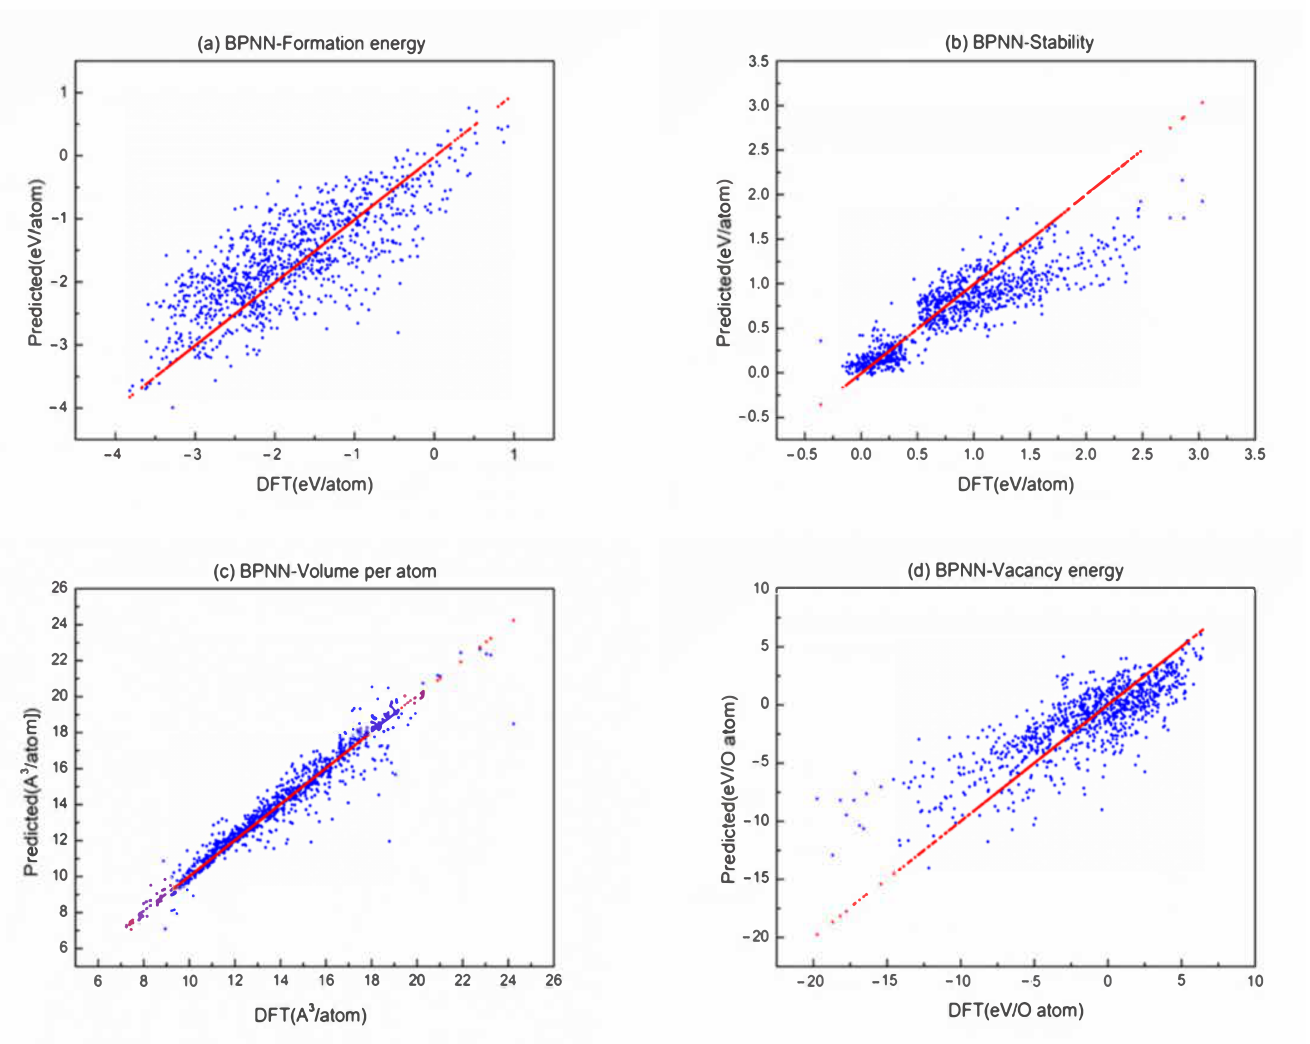
Figure 7. The fitting diagram based on the predicted value of BPNN and the calculated value of DFT is ( a ) the fitting diagram of formation energy, ( b ) the fitting diagram of stability, ( c ) the fitting diagram of volume, and ( d ) the fitting diagram of formation energy of oxygen vacancy. Red points work as reference points, which is ideal values obeyed y =